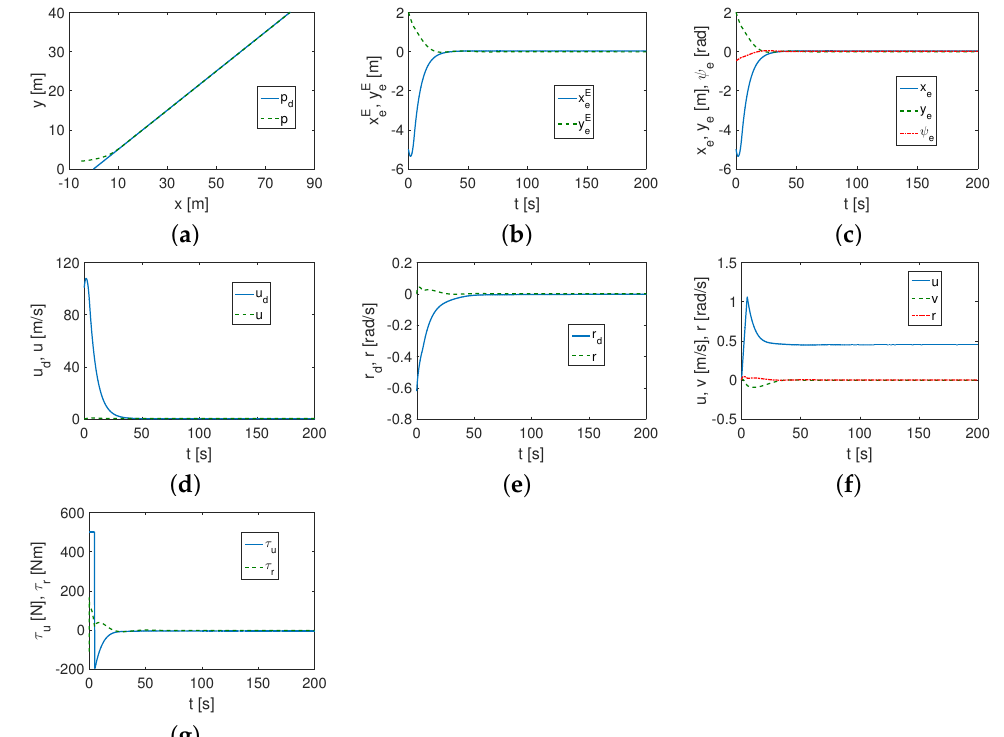
Figure 2. Simulation results for SIRENE–IQV controller and linear trajectory (constant disturbances): ( a ) desired and realized trajectory; ( b ) position errors (E-frame); ( c ) position errors (B-frame) and angu- lar error; ( d ) desired and realized velocity ( u d , u ); ( e ) desired and realized velocity ( r d , r ); ( f ) realized velocities; ( g ) applied force and